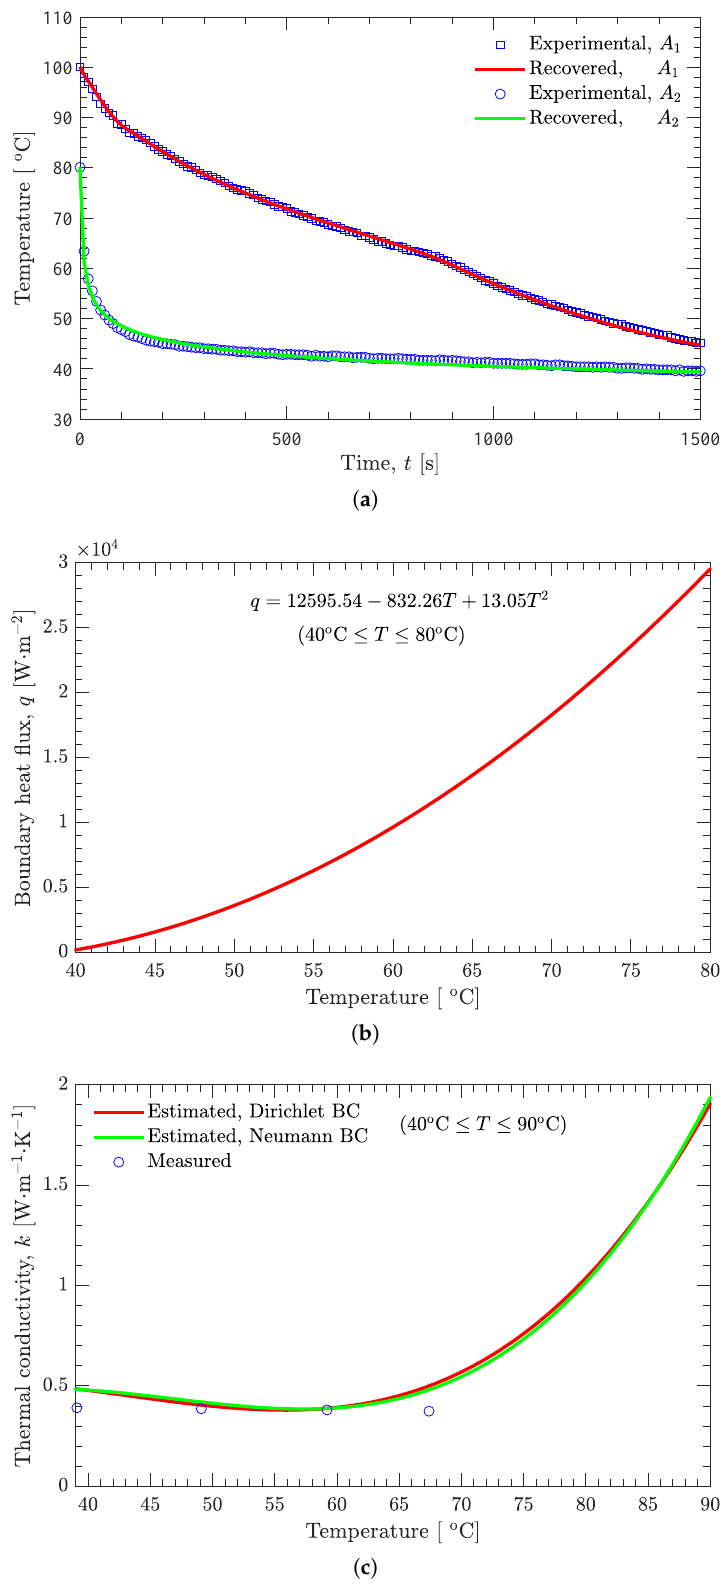
Figure 12. Effect of boundary-condition type on the inverse analysis. ( a ) Temperature. ( b ) Heat flux. ( c ) Thermal